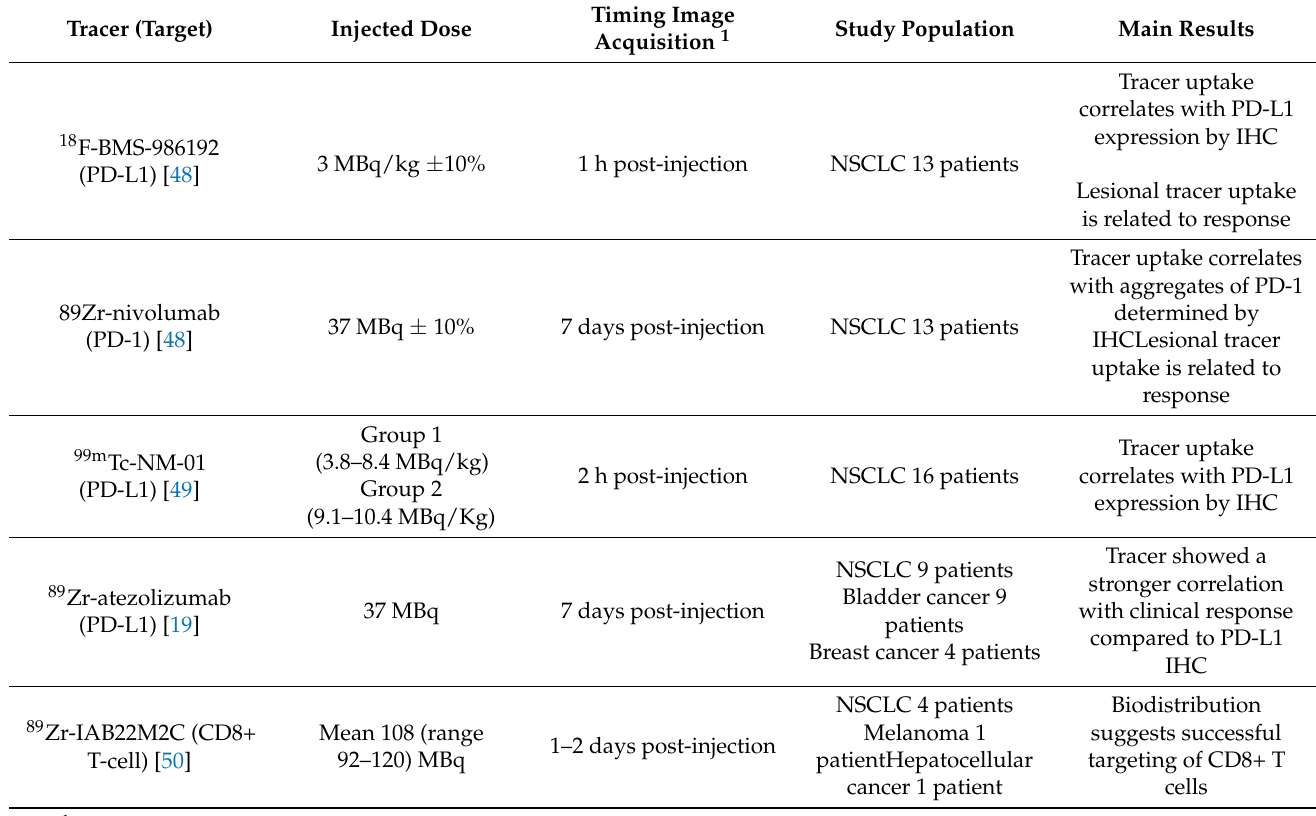
Table 1. Main results of clinical PET studies using immune